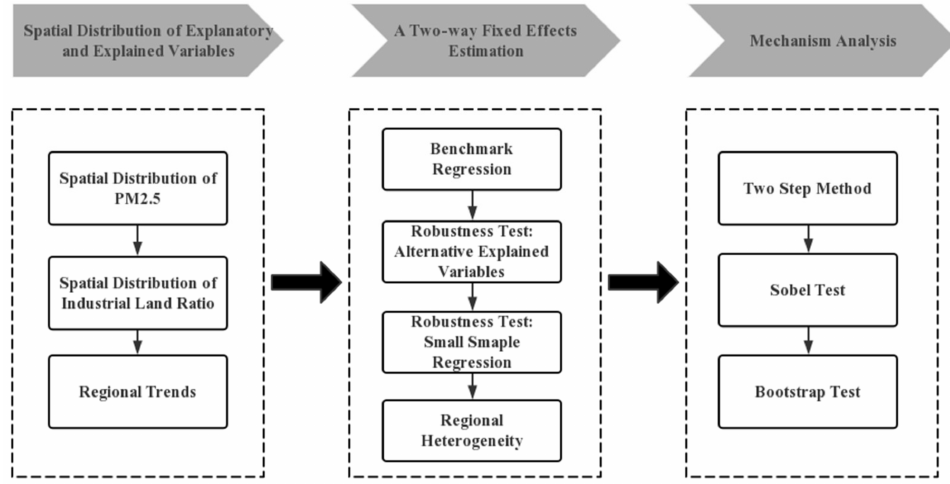
Figure 2. A brief methodology